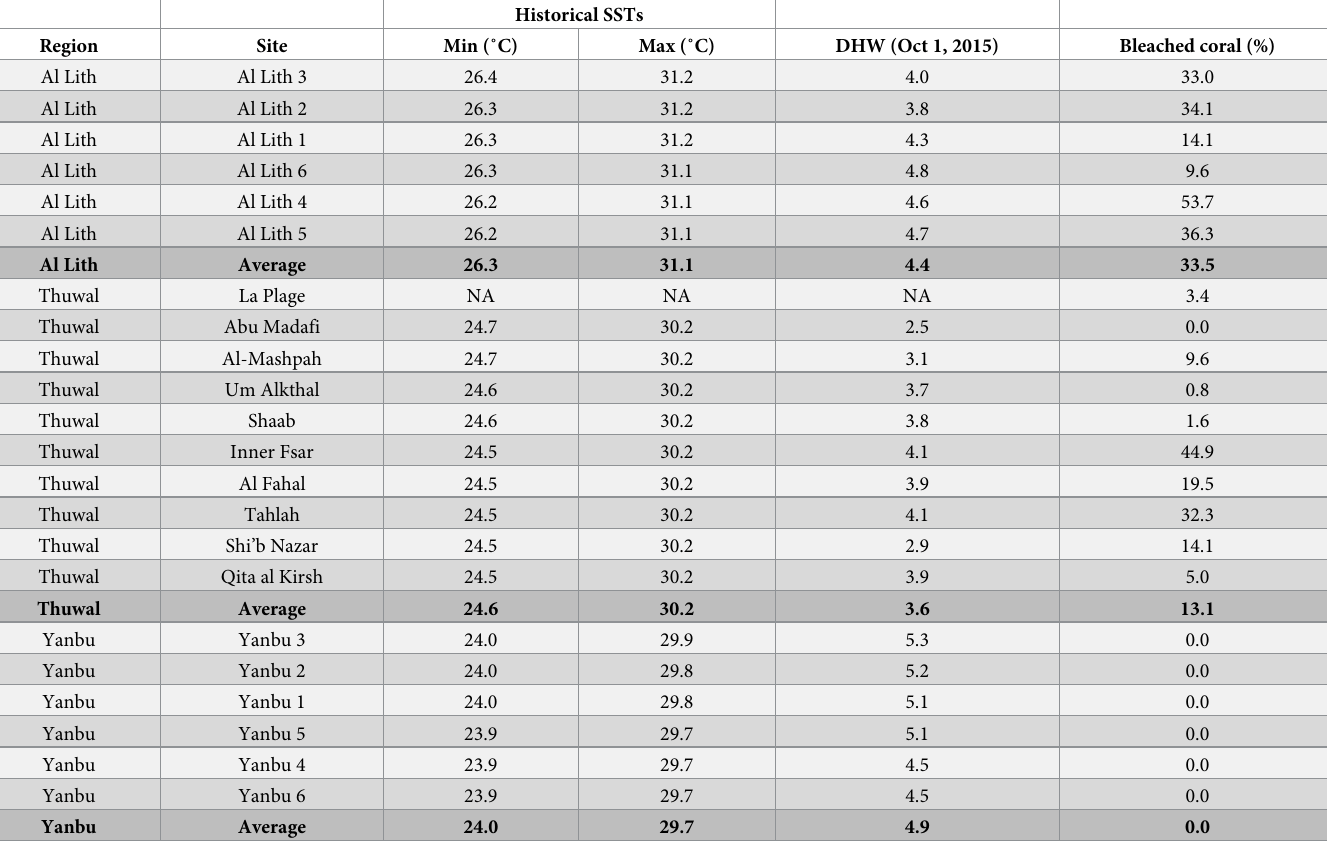
Table 1. Summary of temperature variability and bleaching response in different study sites along the Saudi coast of the Red